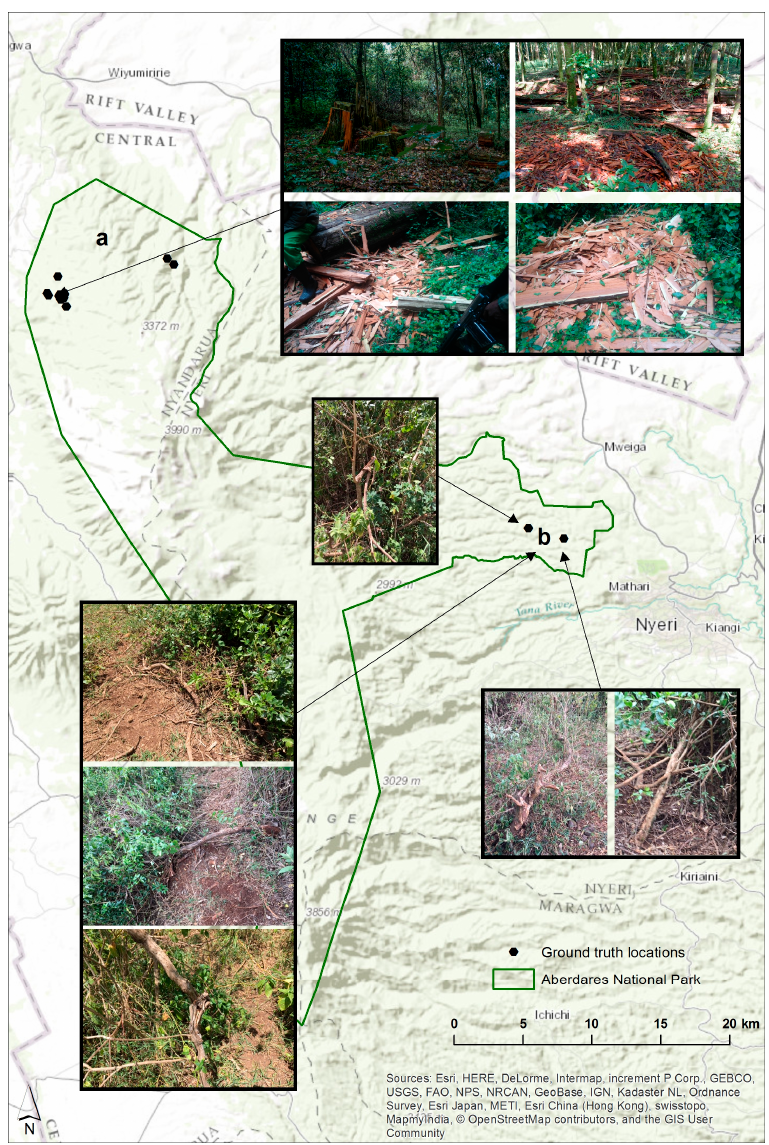
Figure 3. Photos taken during ground truth data collection in 2016 of the Aberdare National Park showing ( a ) Signs on human disturbance in the North and ( b ) Elephant damage in the Eastern areas.